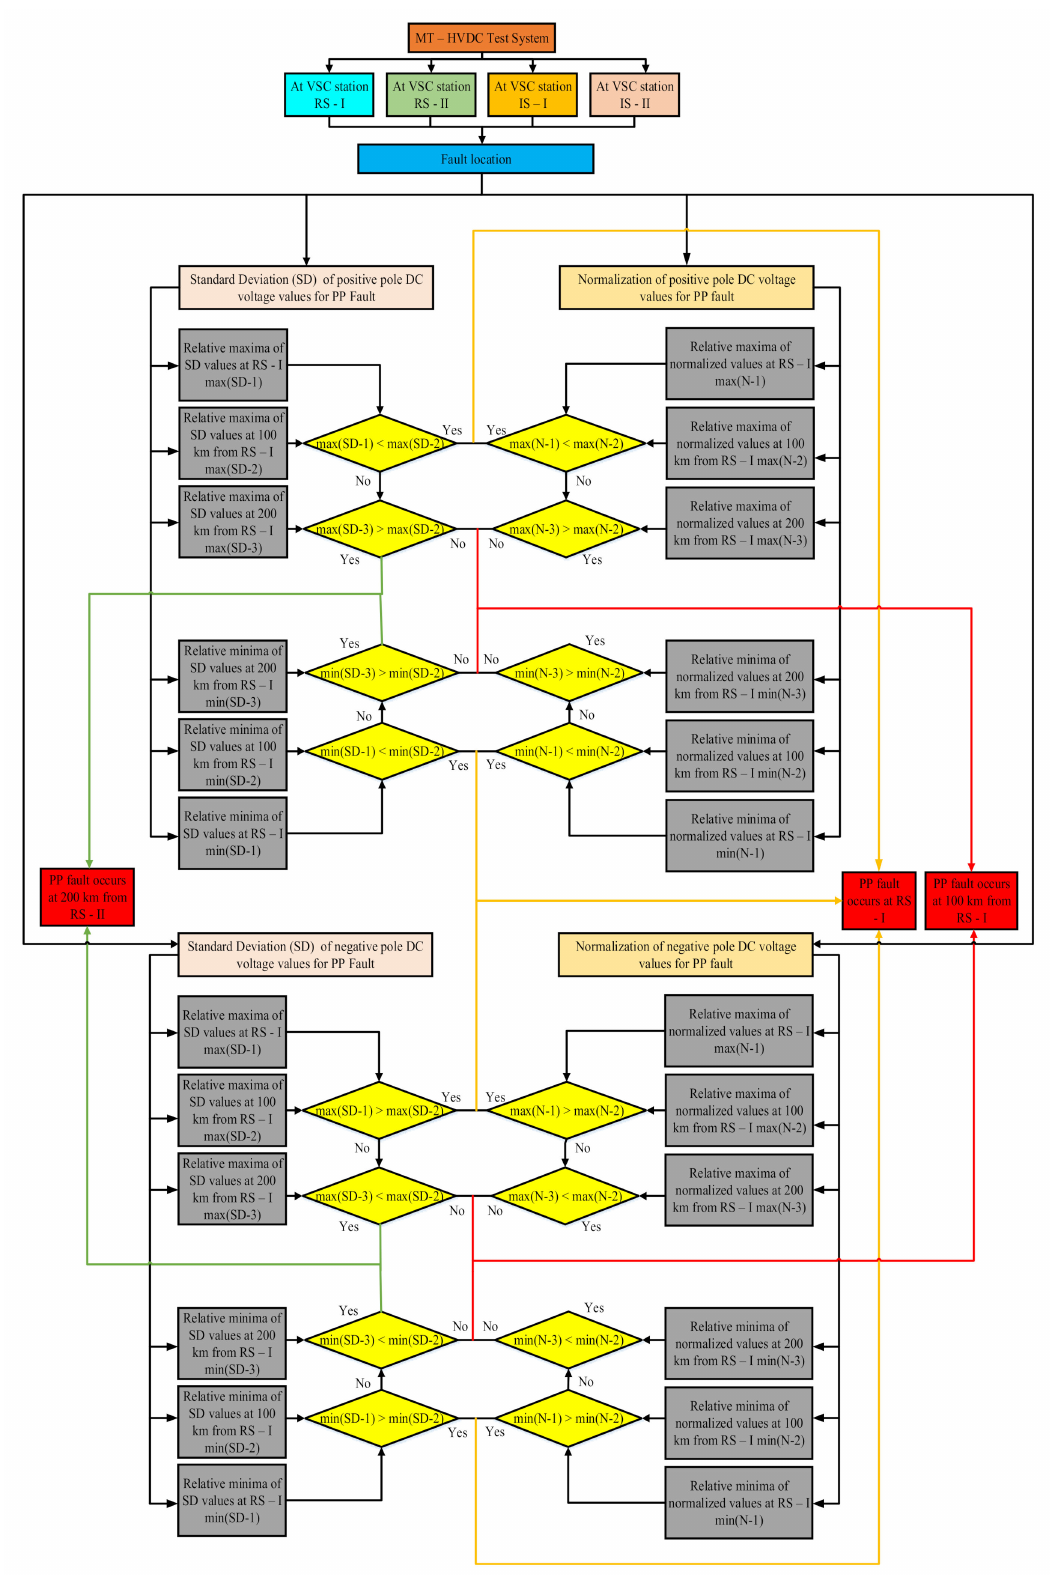
Figure 8. An algorithm for pole-to-pole (PP) fault location finding based on SVM, using supported features of standard deviation and normalization of DC